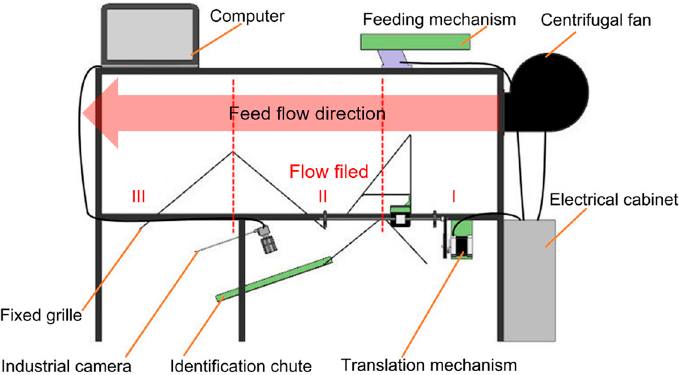
Figure 2. Structure of adaptive winnowing machine. Locations labeled “I”, “II”, and “III” represent adjustable stem collection area, adjustable leaf collection area, and broken leaf collection area, respectively.